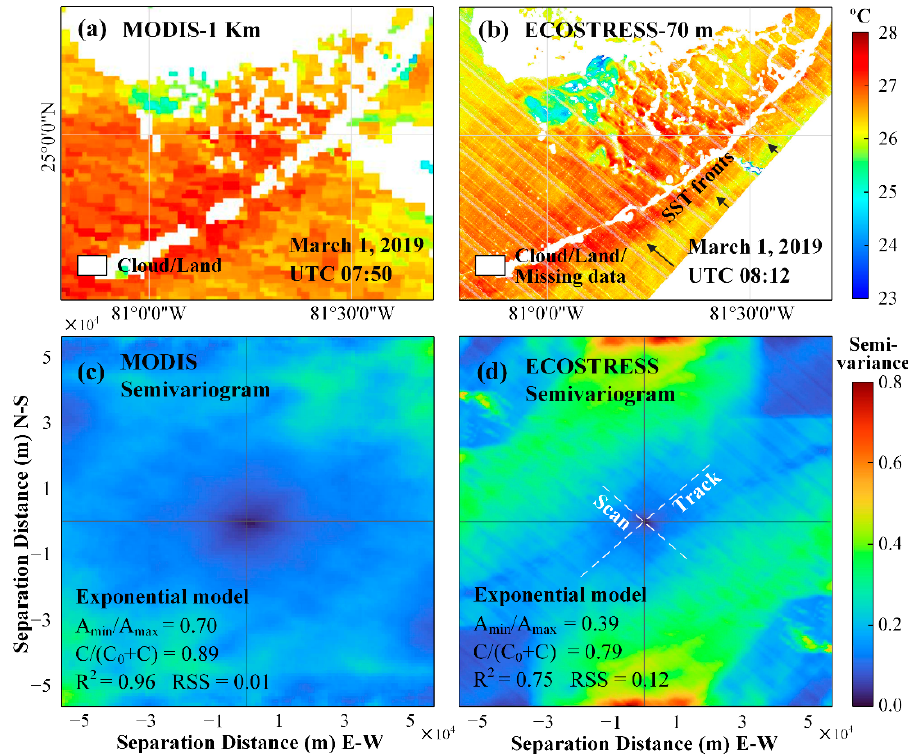
Figure 9. ( a ) MODIS 1-km resolution SST image at 7:50 UTC on 1 March 2019; ( b ) ECOSTRESS 70 m resolution SST image at 8:12 UTC on 1 March 2019. White color represents land, cloud, and masked pixels due to missing data. SST fronts are annotated with arrows in ( b ); ( c ) Two-dimensional semivariogram of MODIS SST in ( a ); ( d ) Two-dimensional semivariogram of ECOSTRESS SST in ( b ). Note that the images are symmetric between negative and positive axis labels. The gray solid lines indicate the north–south and east–west directions, and the white dashed lines represent the along-track and along-scan directions, respectively. SST semivariance is color coded to the right. Among the estimated parameters from the anisotropic exponential semivariogram model, A min and A max represent minor range and major range, and C 0 and C 0 + C represent nugget and sill,